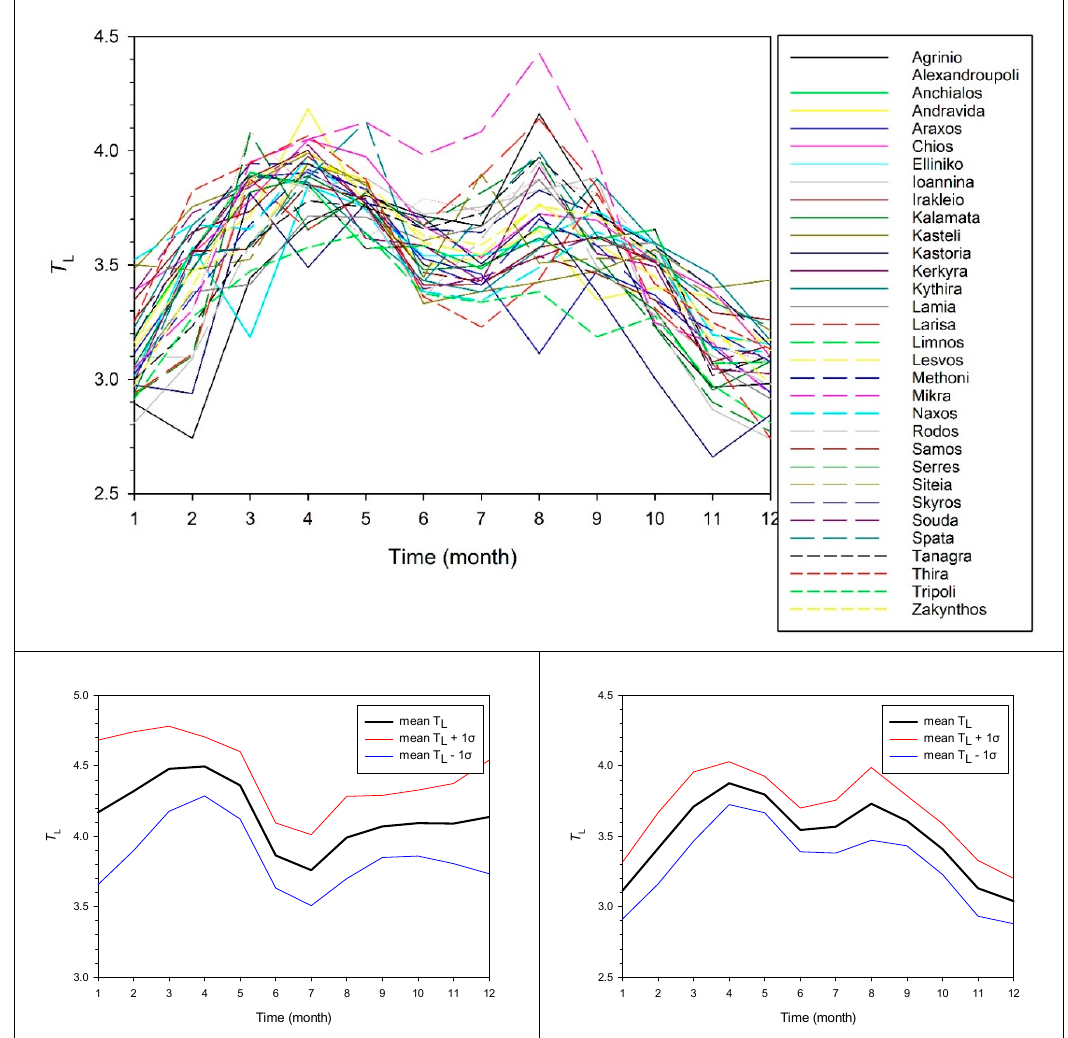
Figure 10. Intra-annual variation of the monthly mean T L values for all 33 stations during TATY. Upper graph: T L variation for all-sky conditions. Middle graph: T L variation for clear-sky conditions. Lower left graph: average T L variation for all-sky conditions (black line). Lower right graph: average T L variation for clear-sky conditions (black line). The red and blue lines represent the ± 1 σ around the mean.